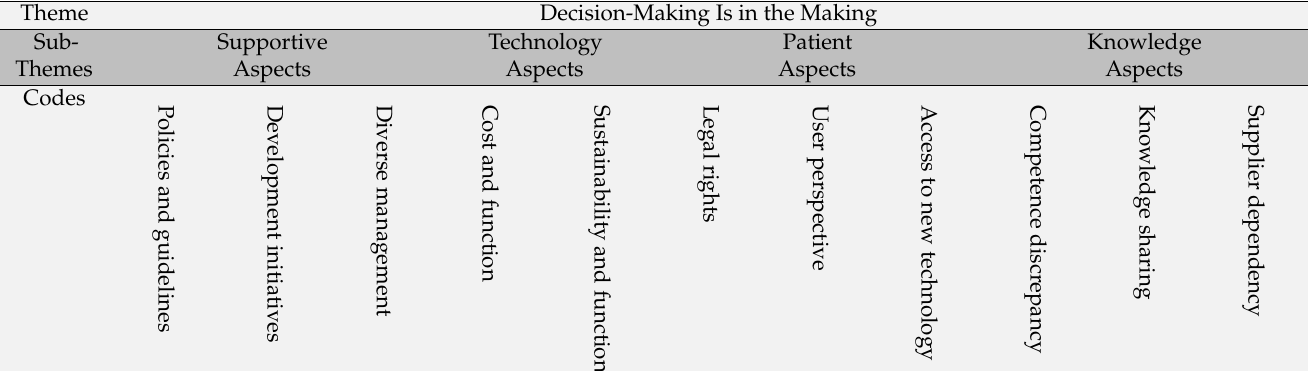
Table 1. Emergent themes, subthemes, and